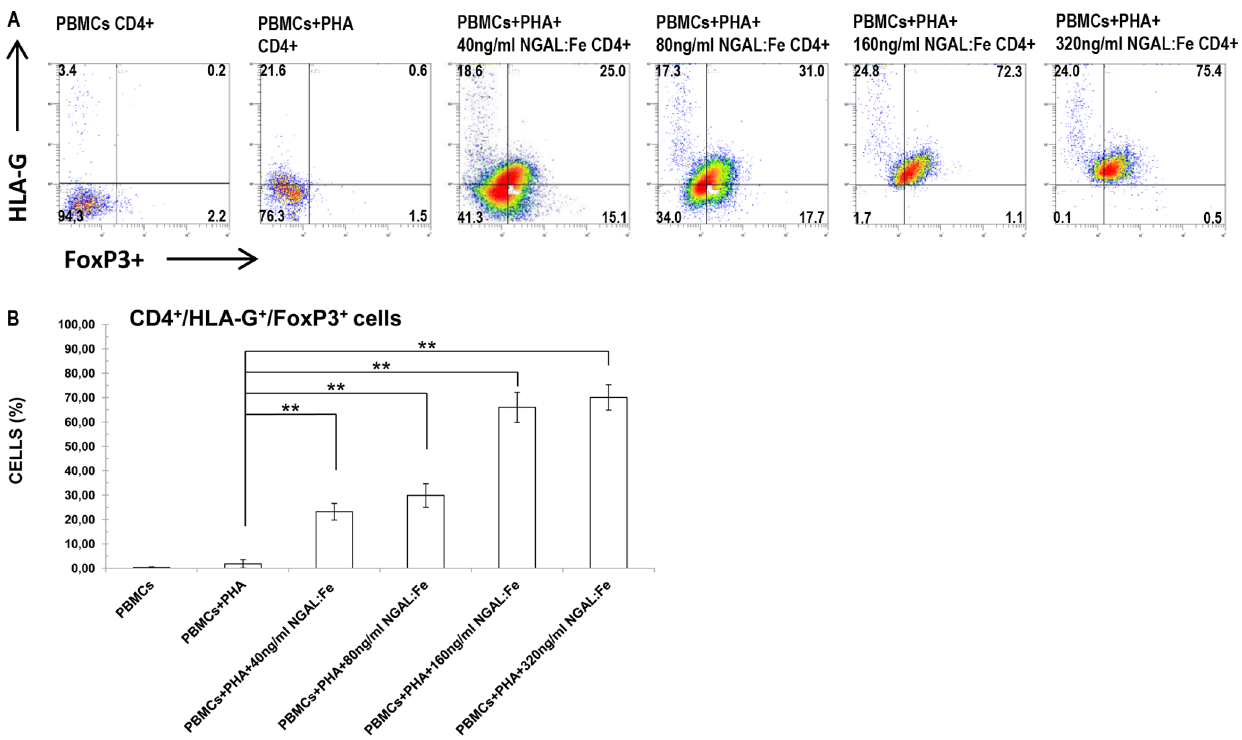
Figure 5. Effect of NGAL on the percentage of CD4 + /HLA-G + /FoxP3 + cell population. Flow cytometry analysis of HLA-G + /FoxP3 + expression on CD4 + cell PHA-activated PBMCs. PBMCs were treated with increasing concentrations of NGAL:Enterobactin:Iron (40 ng/ml, 80 ng/ml, 160 ng/ml, and 320 ng/ml). A dose-dependent raise in the percentage of HLA-G + /FoxP3 + cells was evident. Data are representative of 8 independent experiments. The number in each quadrant represents the percentage of HLA-G + /FoxP3 + cells on gated CD4 + cells of the total population. B) Data are expressed as percentages of CD4 + /HLA-G + /FoxP3 + cells. Means 6 SD; n=8. * p , 0.05.